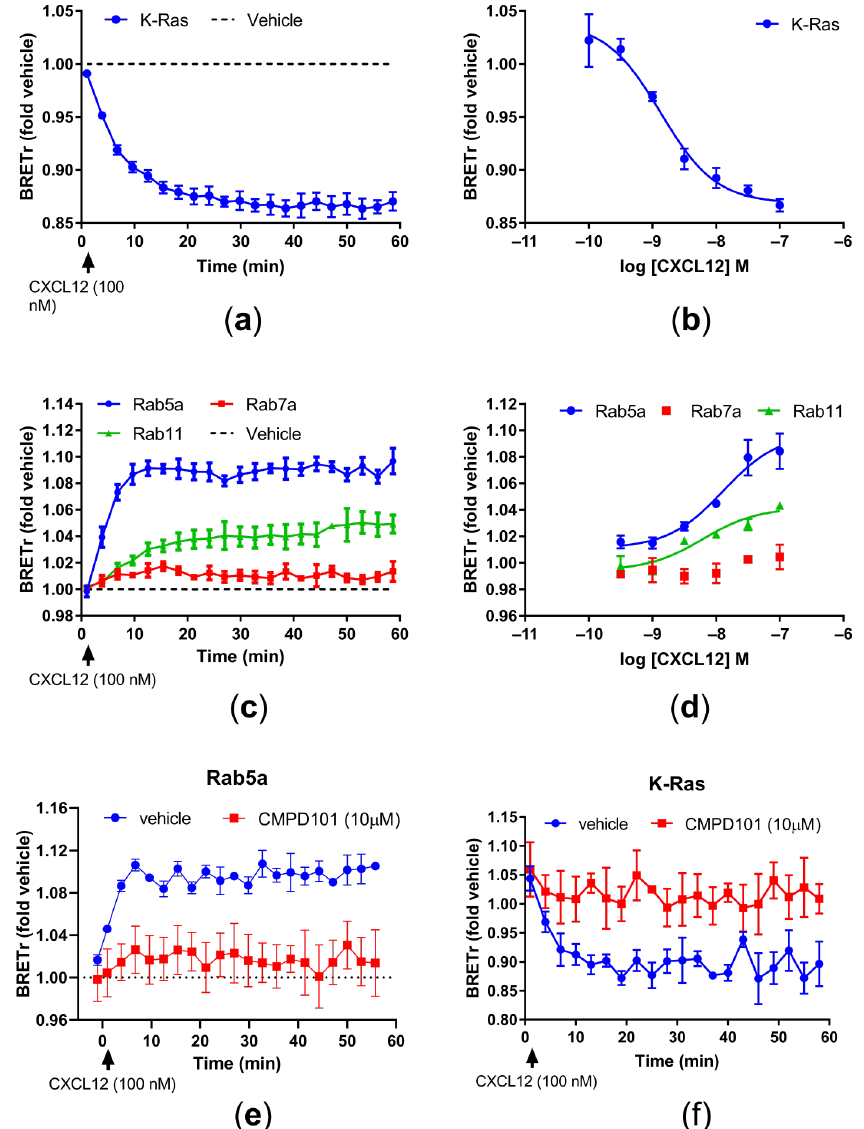
Figure 3. Internalization, recycling and/or degradation of ACKR3 upon CXCL12 stimulation. ( a ) CXCL12-induced K- Ras-Venus co-localization to ACKR3 over time as measured by BRET in HEK293T cells; ( b ) Agonist-induced K-Ras-Venus co-localization to ACKR3 by increasing concentrations of CXCL12 as measured by BRET in HEK293T cells after 30 min stimulation; ( c ) CXCL12-induced ACKR3 translocation to indicated Rab-Venus fusion proteins over time as measured by BRET in HEK293T cells; ( d ) CXCL12-induced ACKR3 translocation to indicated Rab-Venus by increasing concentrations of CXCL12 as measured by BRET in HEK293T cells after 30 min stimulation; ( e ) CXCL12-induced ACKR3 translocation to Rab5a-Venus over time, in presence or absence of 30 µ M CMPD101 as measured by BRET in HEK293T cells; ( f ) CXCL12- induced K-Ras-Venus co-localization to ACKR3 over time, in presence or absence of 10 µ M CMPD101 as measured by BRET in HEK293T cells. Representative curves of three independent experiments with triplicates shown as mean ±